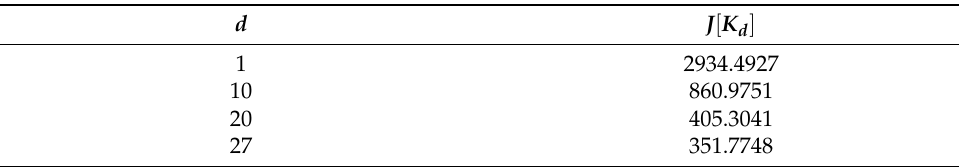
Table 3. Solution results for different mini-batch sizes.